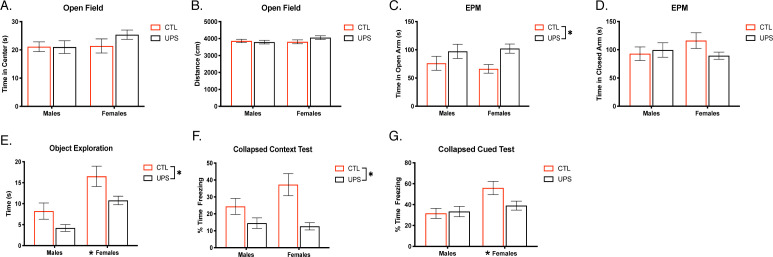
Effects of unpredictable postnatal stress and sex on adult behavior.Time in the center (A) and distance traveled in the OF (B). Time spent in the open (C) and closed arms (D) of the EPM. Time exploring objects in an arena (E). Average freezing behavior in contextual fear conditioning test (F) and during cue presentations in novel context (G) (n = 12–23 per rearing and sex group). Mean and SEM, *p<0.05. Figure 2—source data 1.Figure 2—source data 1.Raw data for behavioral outcomes.